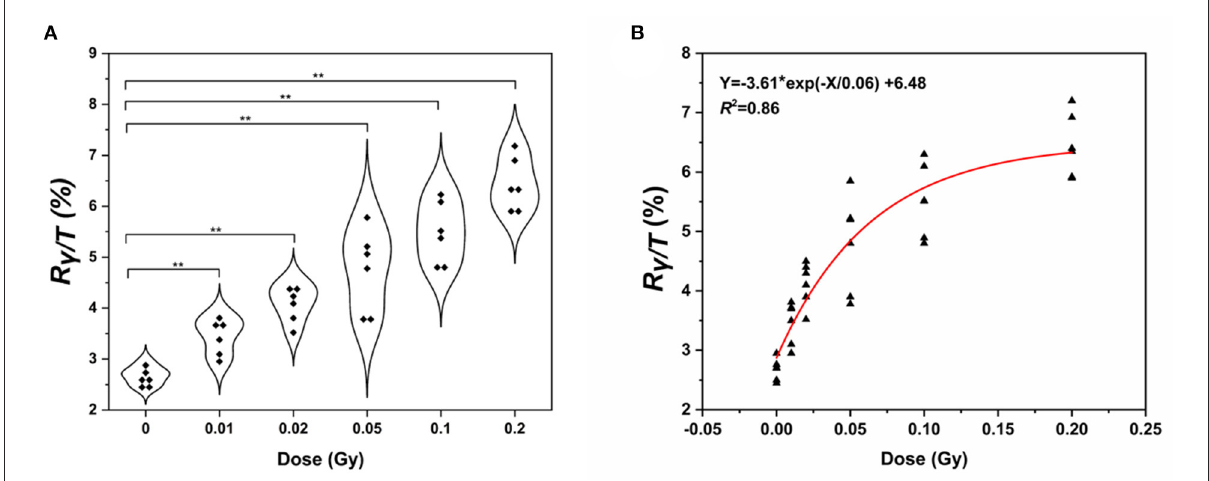
FIGURE6 Detection of γ -H2AX levels in human peripheral blood lymphocytes. (A) Violin chart and (B) fitting curve of γ -H2AX in the lymphocytes of peripheral blood exposed to low doses of γ - rays of 0.01–0.2Gy γ -ray ( n ≥ 3, mean ± SD; ** p ≤ 0.01, *represents